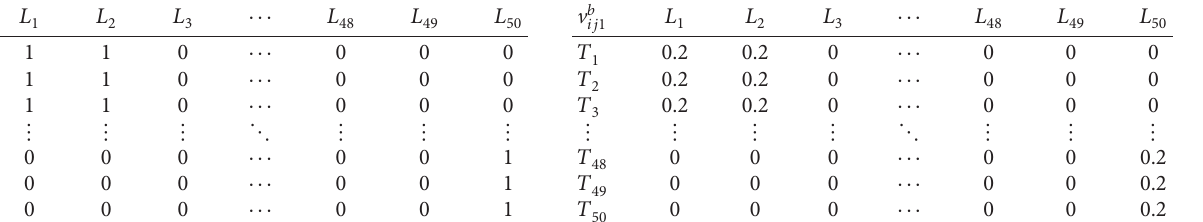
� [ v b ] for tenants’ ij 1 50 × 50 1